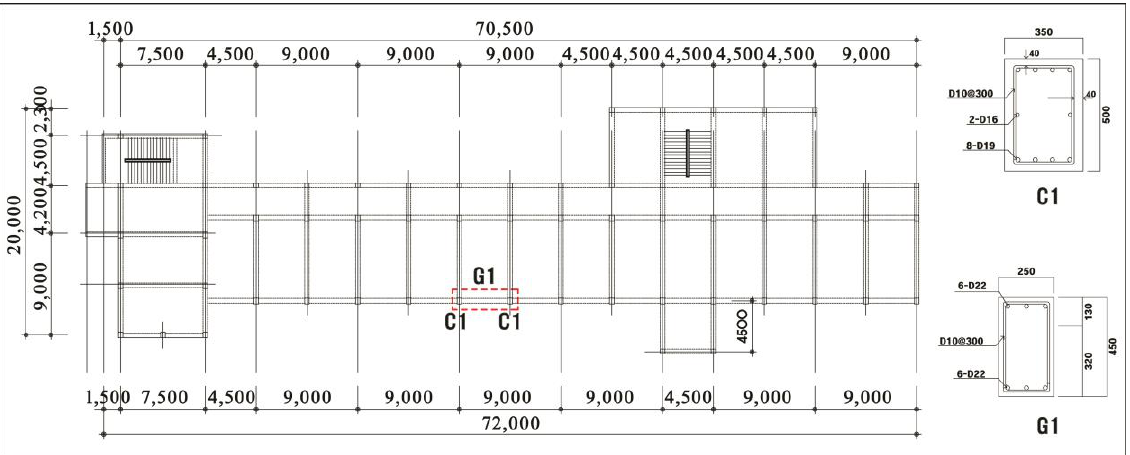
Figure 4. Wall-type Kagome damping system. ( a ) WKDS installation location, ( b ) WKDS construc- tion.